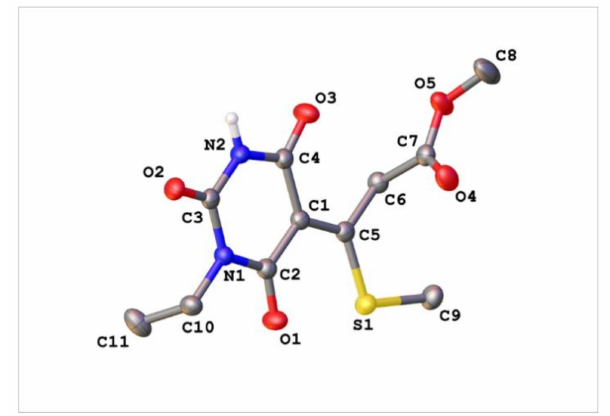
Figure A3. Crystal structure of compound 7b .